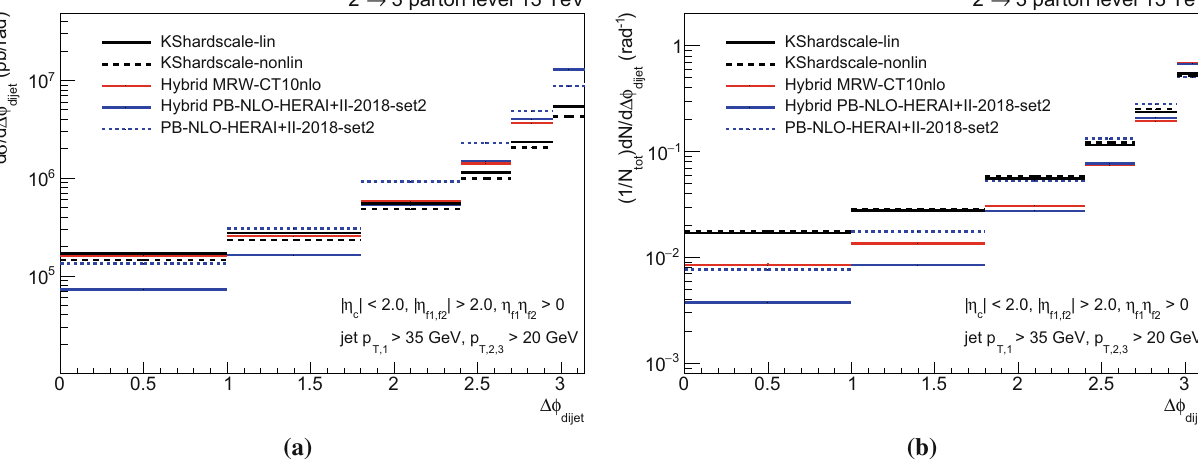
well as to test and perhaps further constrain the PDFs used in the